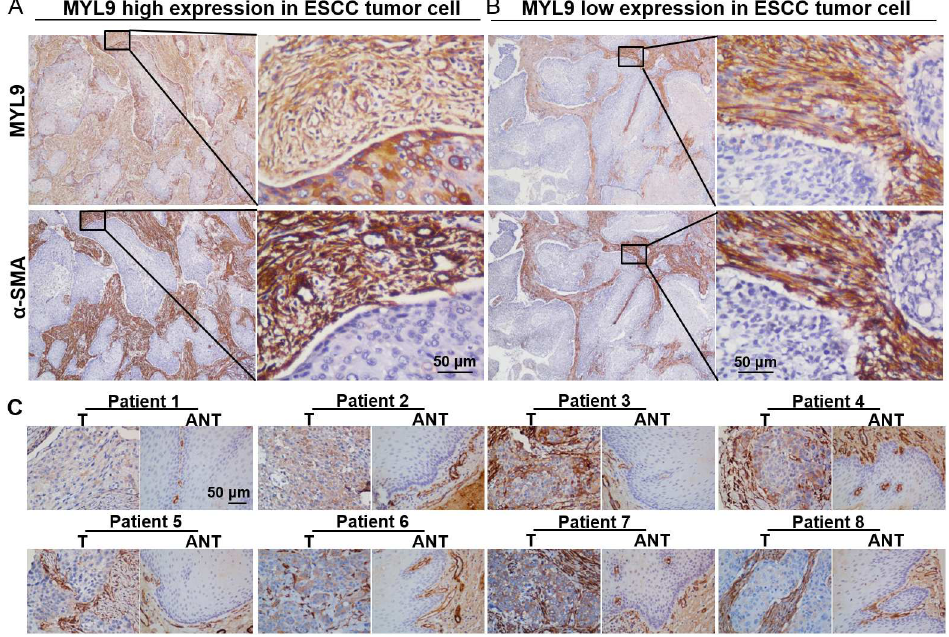
Fig 2. IHC characteristics of MYL9 in ESCC specimens. (A, B) Stromal cells in tumor tissues were positive for MYL9. Anti– α -SMA stainingwas usedto distinguish stromal regions. (A) Representative stainingof high MYL9 expression in tumor cell cytoplasm(left, × 40magnification; right, × 400magnification).(B) Representative stainingof low MYL9expressionin tumor cell cytoplasm(left, × 40magnification; right, × 400magnification). Scalebar = 50 μ m.(C) IHC assayof MYL9 proteinexpression in eight pairedESCCtissues.Scalebar = 50 μ m.